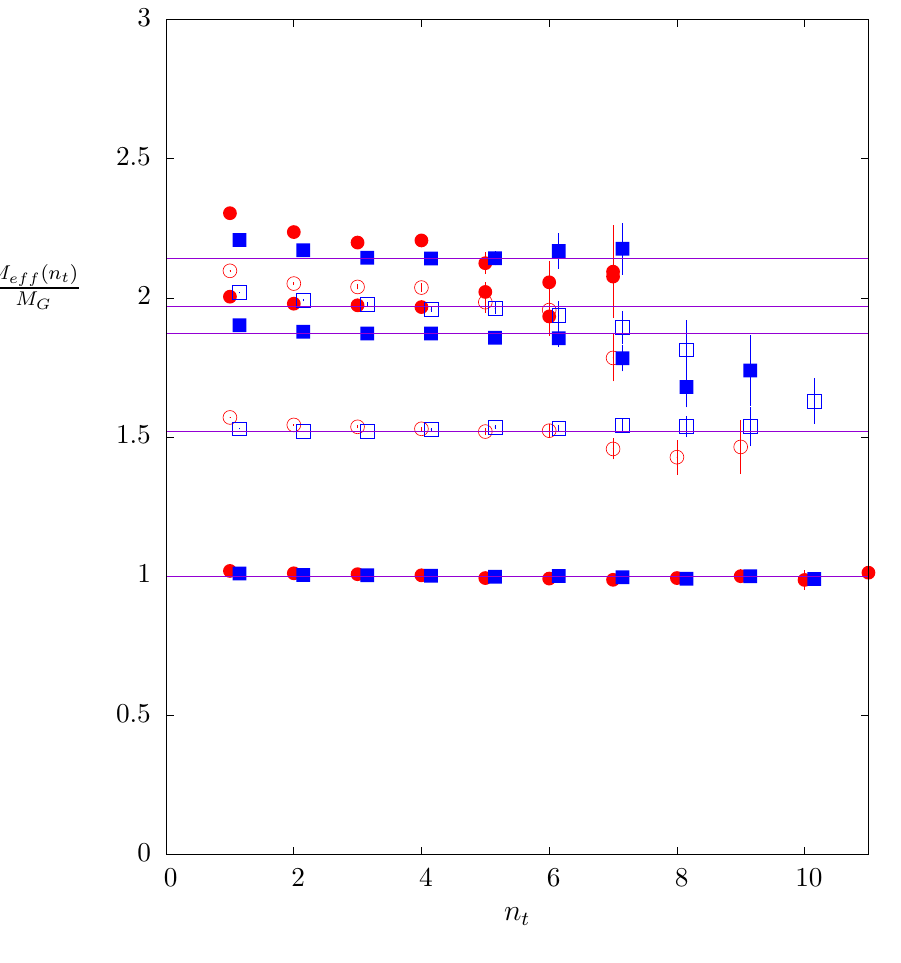
Figure 28 . Lightest (cid:12)ve 0 + glueball e(cid:11)ective masses in SU(4) ( (cid:3) , (cid:4) ) and SO(6) ( (cid:14) , (cid:15) ), in units of their respective mass gaps, and at the smallest values of a in each